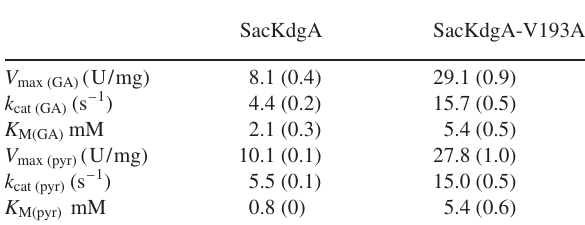
Table 1. Biochemical data for SacKdgA and mutant V193A, deter- mined at 50 °C. Values between brackets are standard deviations.